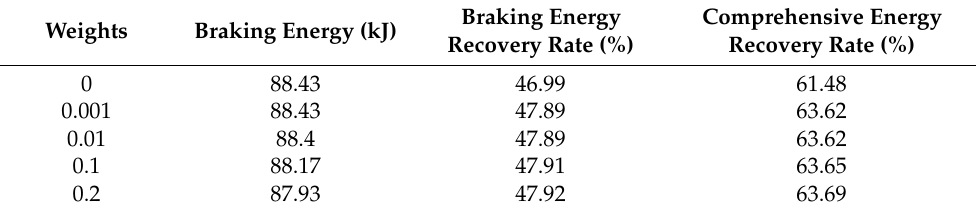
Table 4. Comparison of energy recovery rates under different efficiency weights.